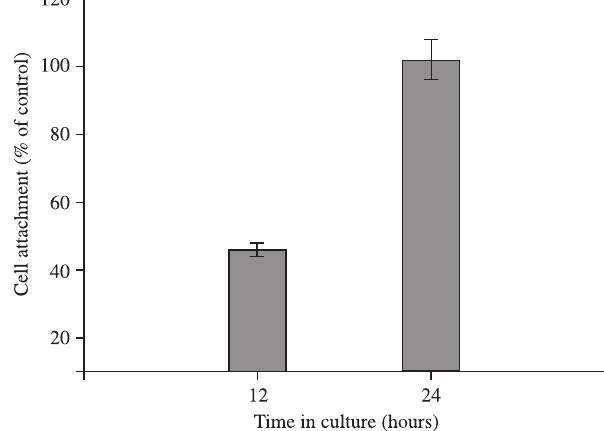
Figure 3. Adhesion of osteoblasts cells cultured onto ZnAl incubation period of 12 and 24 hours expressed as the percentage of attached cells in comparison with control